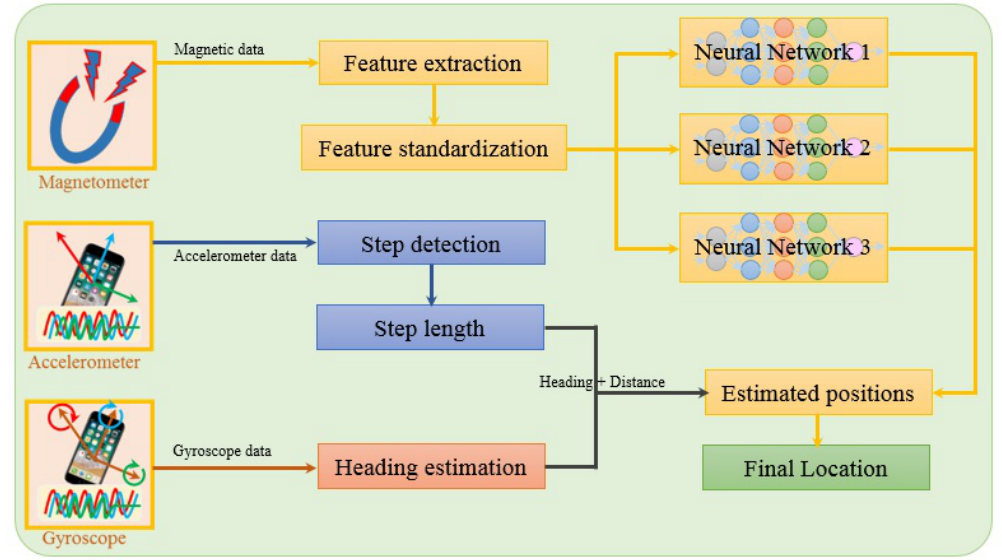
Figure 4. Architecture of the proposed approach.